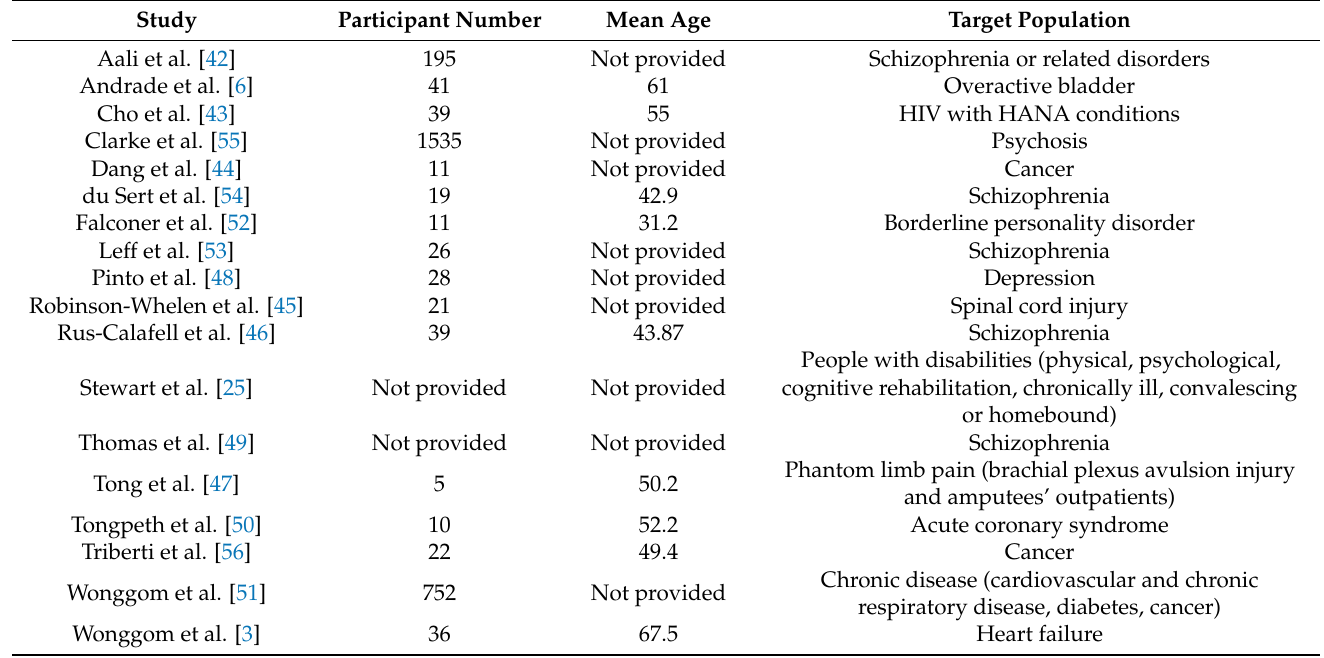
Table 2. Characteristics of included papers (part